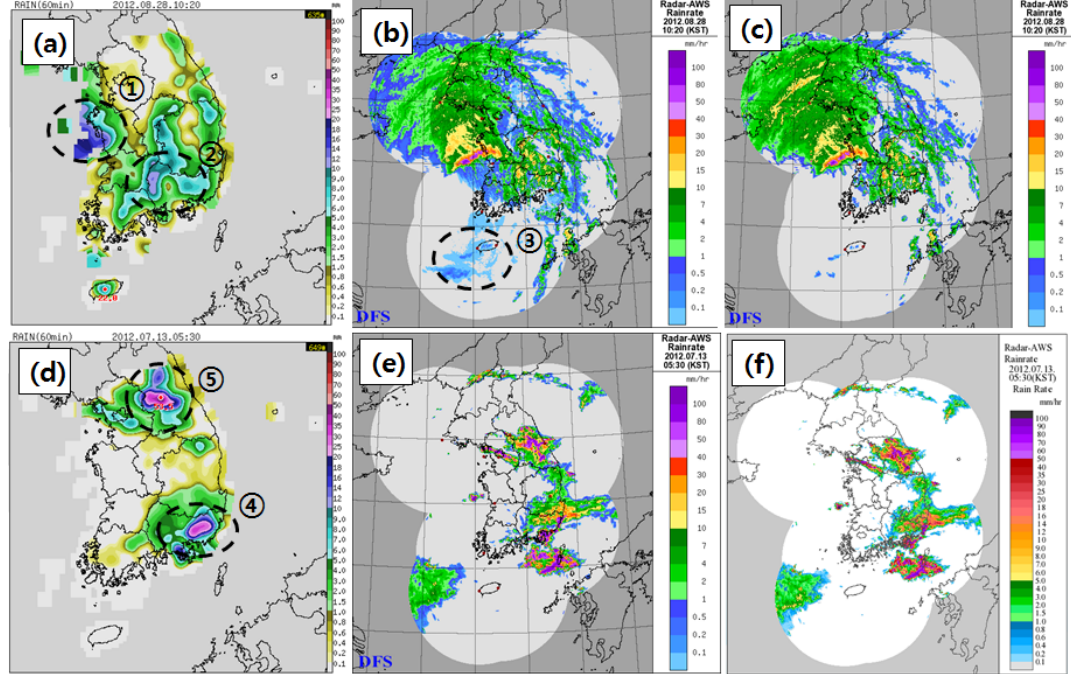
Figure 4. Comparison of precipitation estimates: between automatic weather stations (AWS) and quality control methods ( a ) Observation from AWSs, ( b ) fuzzy, ( c ) ORPG at 1020 LST on 28 August in 2012; between AWS and bias correction methods ( d ) AWS, ( e ) G/R ratio, ( f ) LGC at 0530 LST on 13 July in 2012.